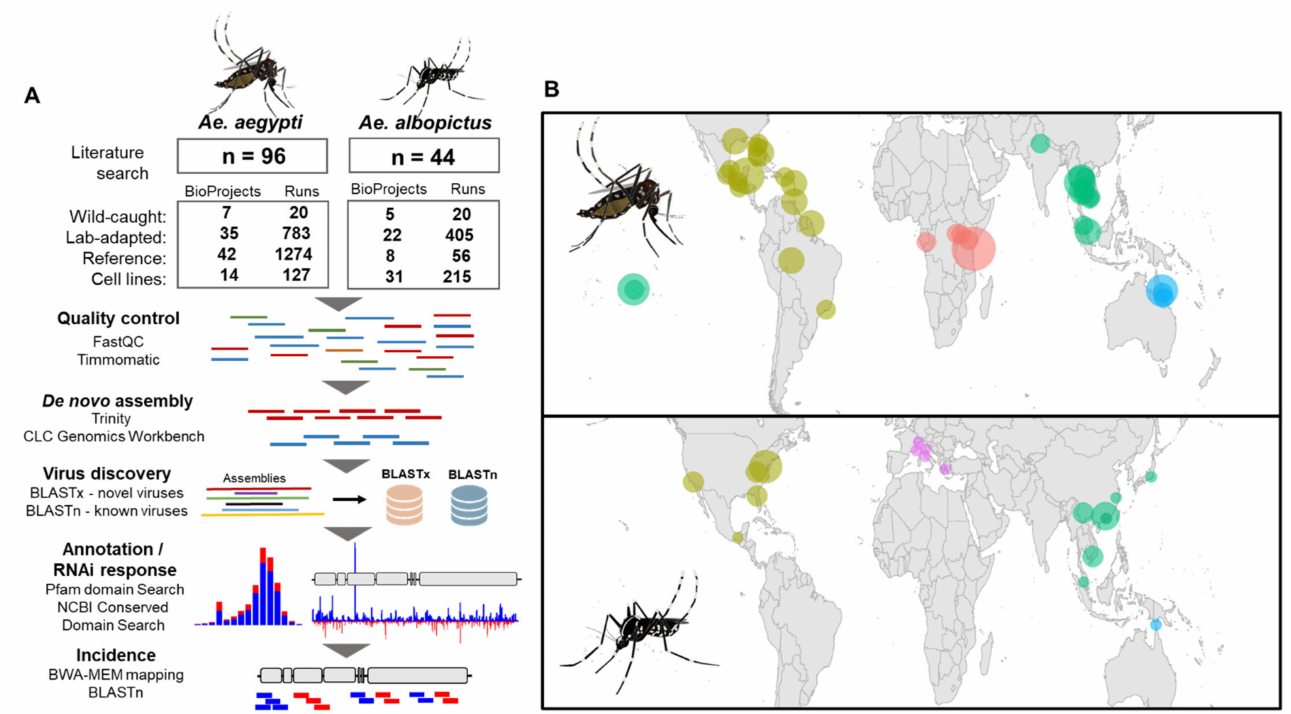
Figure 1. Virus discovery and geographic sample incidence in Aedes aegypti and Aedes albopictus . ( A ) The bioinformatics pipeline for virus discovery and virus incidence of Ae. aegypti and Ae. albopictus viruses. ( B ) Sample locations of Ae. aegypti (top) and Ae. albopictus (bottom). Samples are coloured based on the geographic region of the original catch location. The size of the circle indicates the number of independent catch locations and are coloured as follows: African samples (red), Australian samples (blue), Asian samples (green), American samples (gold), and European samples